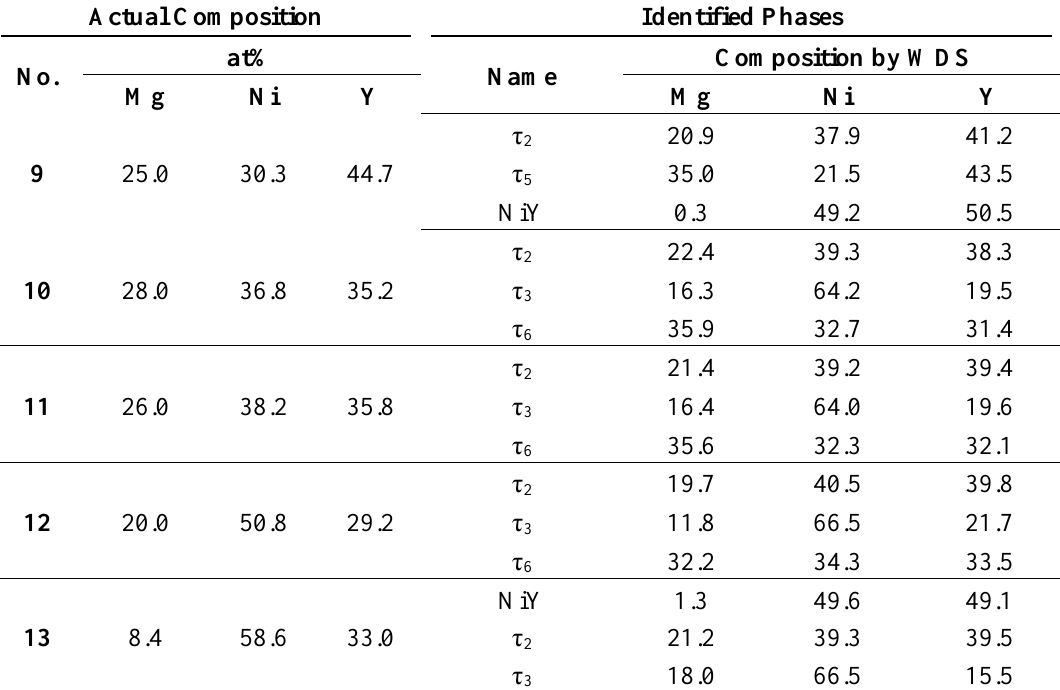
Table 5. WDS data of the samples 19–26 annealed at 673 K. Actual Composition Identified